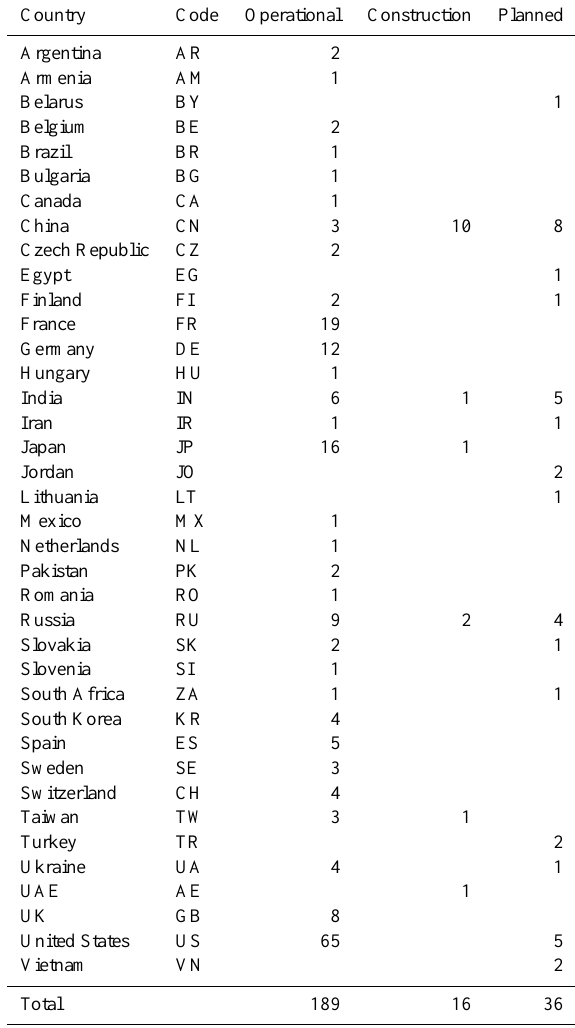
Table 1. Number of operational, under construction and planned nuclear power stations included in our model per country, based on the WNA reactor database. Country Code Operational